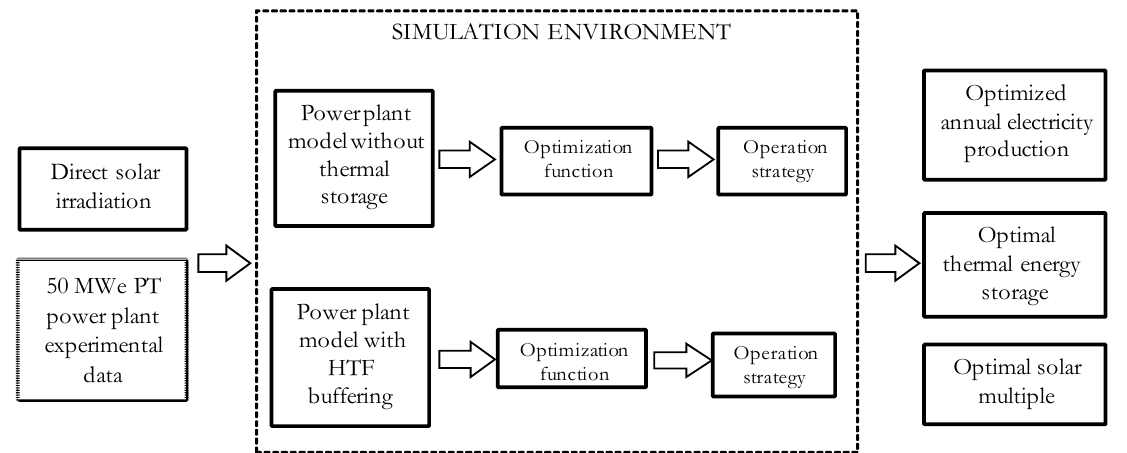
Figure 5. Structure simulation environment and data flow.